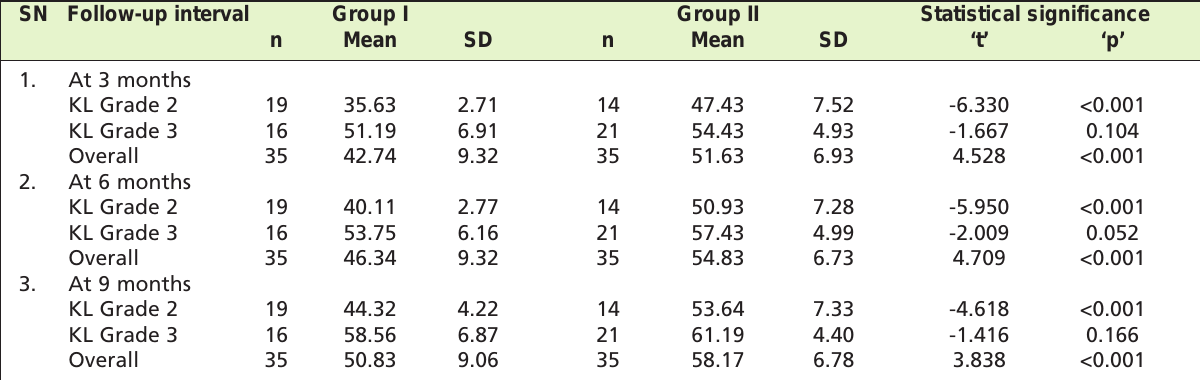
Comparison of post-intervention WOMAC scores at different follow-up intervals Table V: